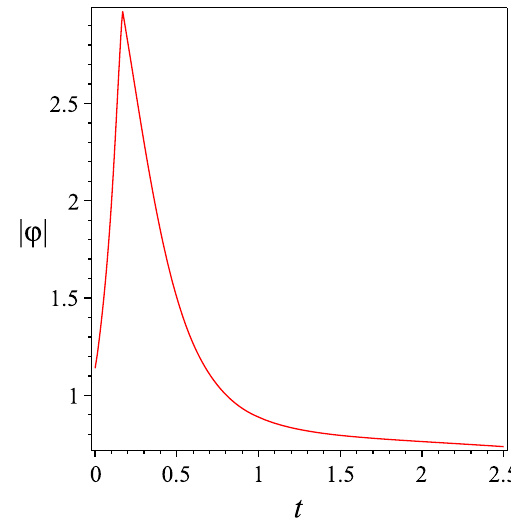
Fig. 2 The evolution of the scale factor with respect to time t